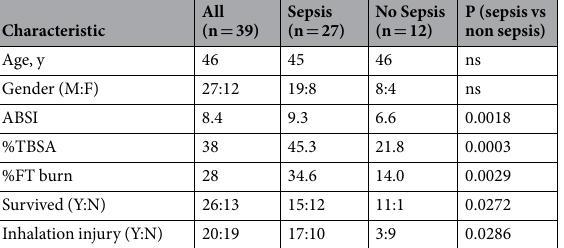
Table 1. Patient demographics. Sepsis and no-sepsis variables were analysed by Mann-Whitney (continuous variables) or Chi-squared test (categorical variables). Abbreviations: ABSI = abbreviated burn severity index, %TBSA = percentage total body surface area, %FT = percentage full thickness